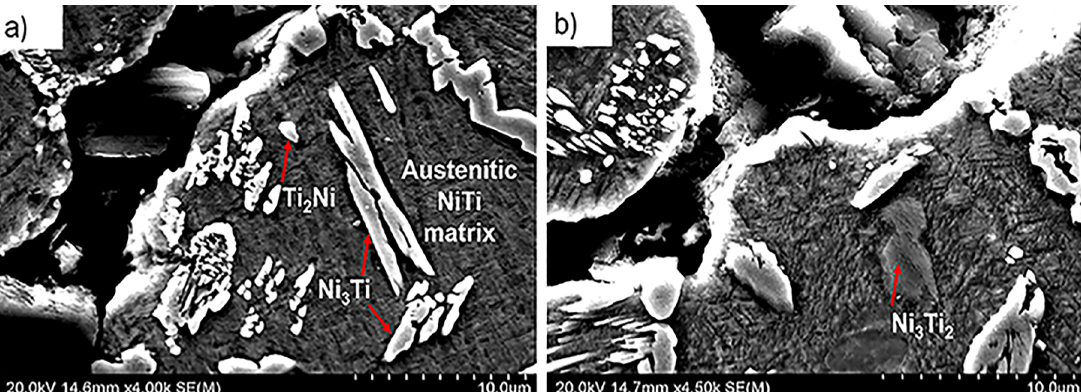
Figure 7. SEM images of sintered samples processed under condition 4. Different phases have been identified based on EDS elemental analysis a) Austenitic NiTi, Ni3Ti and Ti2Ni b) decomposition of the NiTi phase at 620°C during furnace